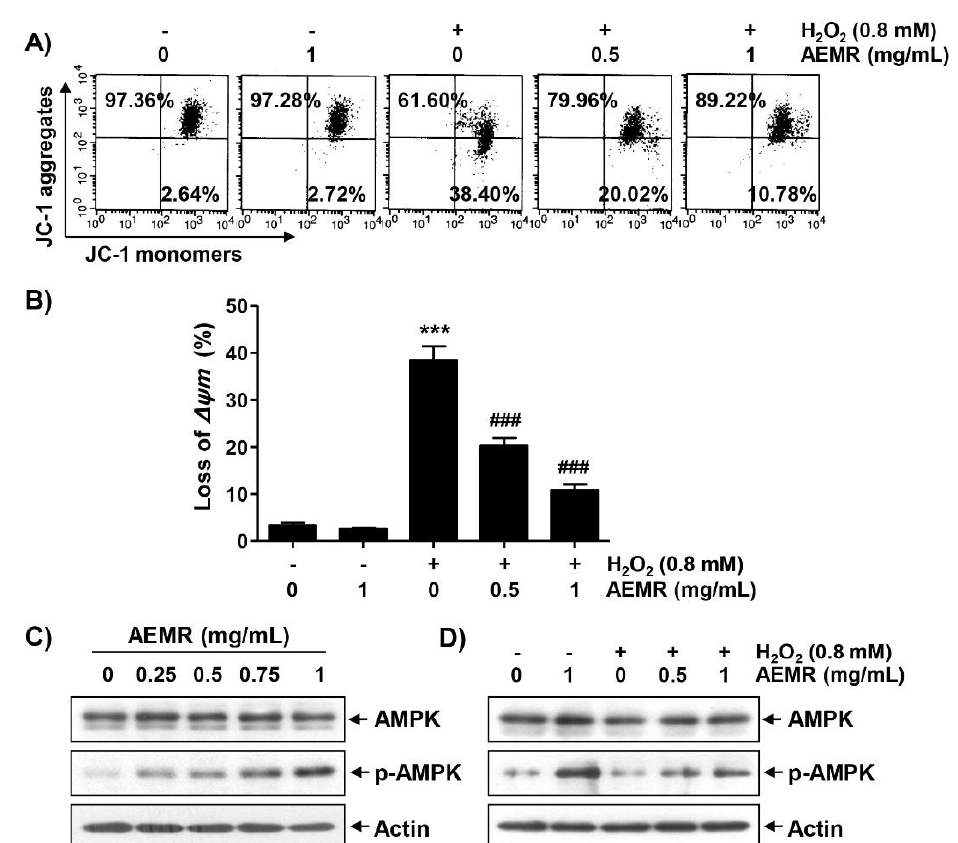
Figure 2. Attenuation of H 2 O 2 -induced mitochondrial dysfunction and activation of AMP-activated protein kinase (AMPK) by AEMR in C2C12 cells. Cells were treated with the indicated concentrations AEMR or 0.8 mM H 2 O 2 for 24 h, or pretreated with AEMR for 1 h prior to exposure to H 2 O 2 for 24 h. ( A , B ) Mitochondrial membrane potential (MMP) was assessed by flow cytometry after 5,5 (cid:48) 6,6 (cid:48) -tetrachloro-1,1 (cid:48) ,3,3 (cid:48) -tetraethyl-imidacarbocyanine iodide (JC-1) staining. ( A ) Representative profiles of flow cytometry analysis are shown. ( B ) Ratios of JC-1 aggregates to monomers are presented as mean ± SD of triplicate independent experiments (*** p < 0.001 vs. control cells; ### p < 0.001 vs. H 2 O 2 -treated cells). ( C , D ) Expression of AMPK and p-AMPK was measured by western blot analysis. Anti-actin immunoblotting revealed relative amounts of protein in each